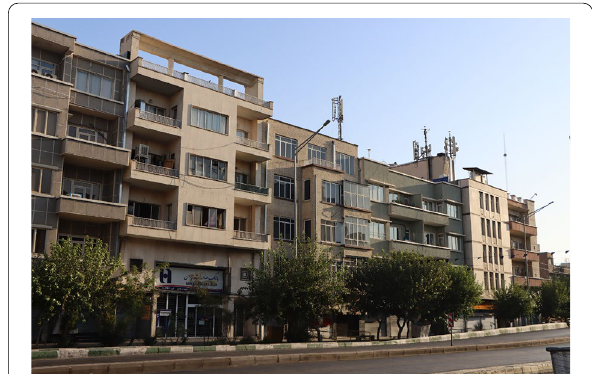
Fig. 2 The urban facade buildings of the Pahlavi period in Tehran, Enghelab St.